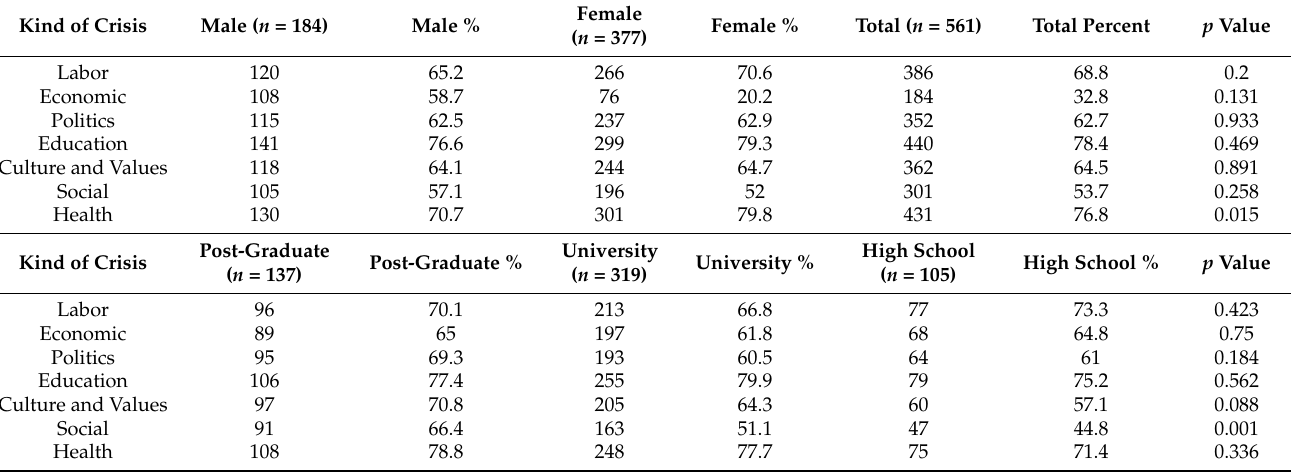
Table 2. Distribution of the sample by sex and education level, according to type of crisis identified 1